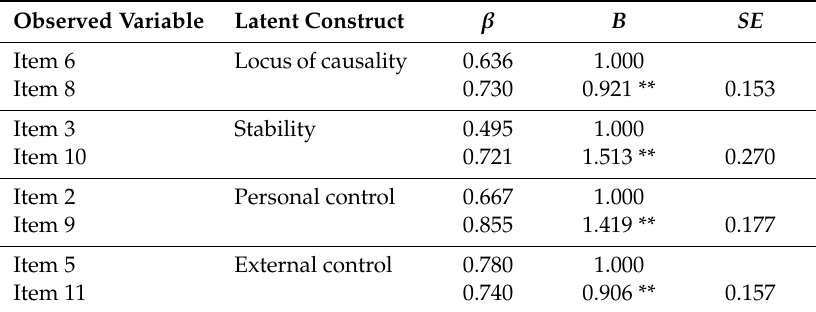
Table 3. CFA Results for Procrastination Attributions.